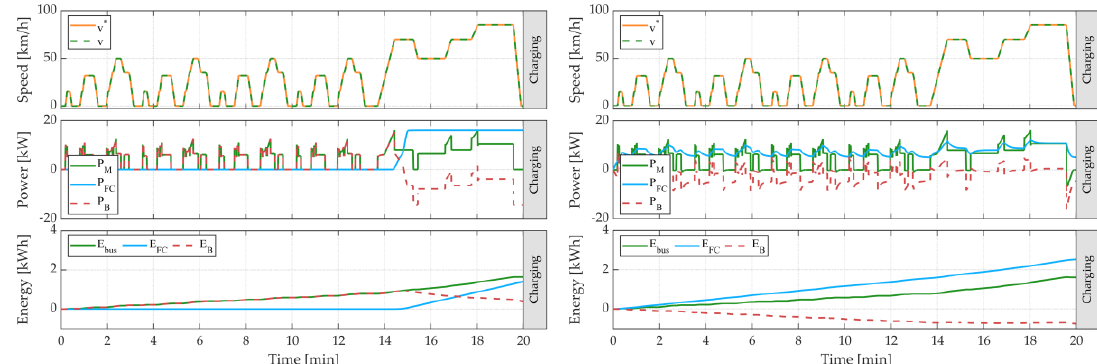
Figure 15. Powers and energies achieved over NEDC by H-EMS ( left ) and S-EMS ( right ).